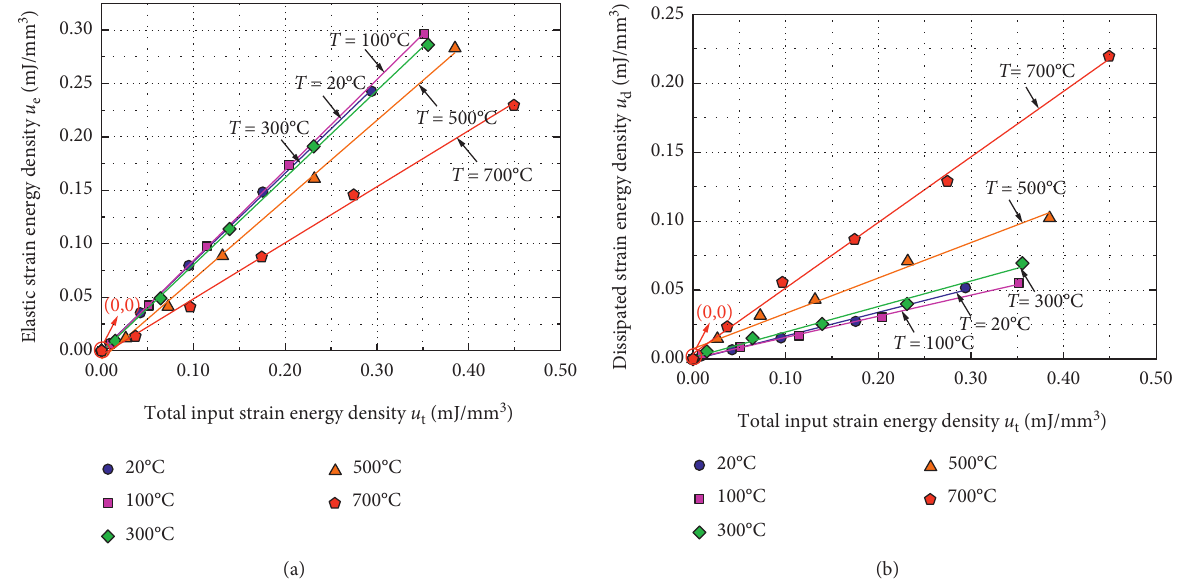
Figure 3: Mechanical parameters at different temperatures: (a) peak compressive strength σ modulus (E) [48].